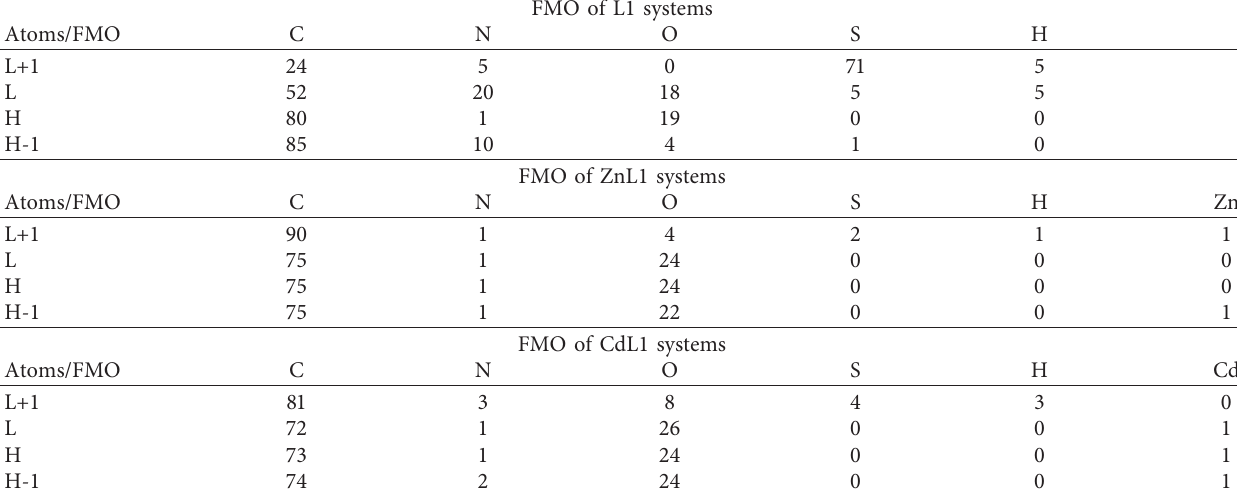
Table 4: Percentage fragmentation contributions in